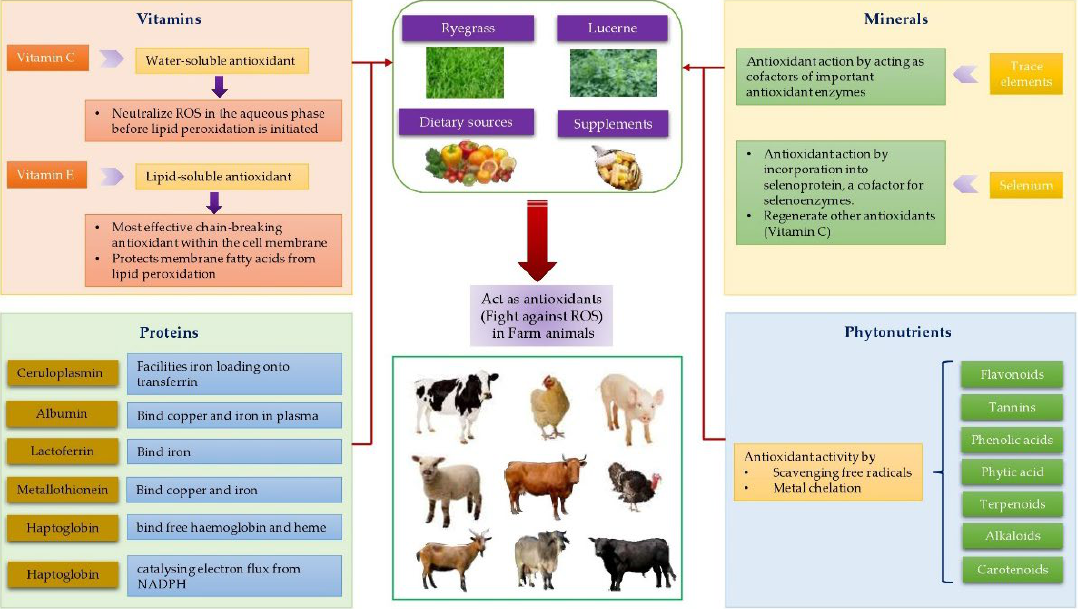
Figure 9. Non-enzymatic defense systems contributed by vitamins, minerals, proteins, and phytonutrients found in dietary sources. Different components from vitamins, minerals, proteins, and phytonutrients exhibit antioxidant activities in the biological systems by scavenging free radicals and/or chelating metal ions.